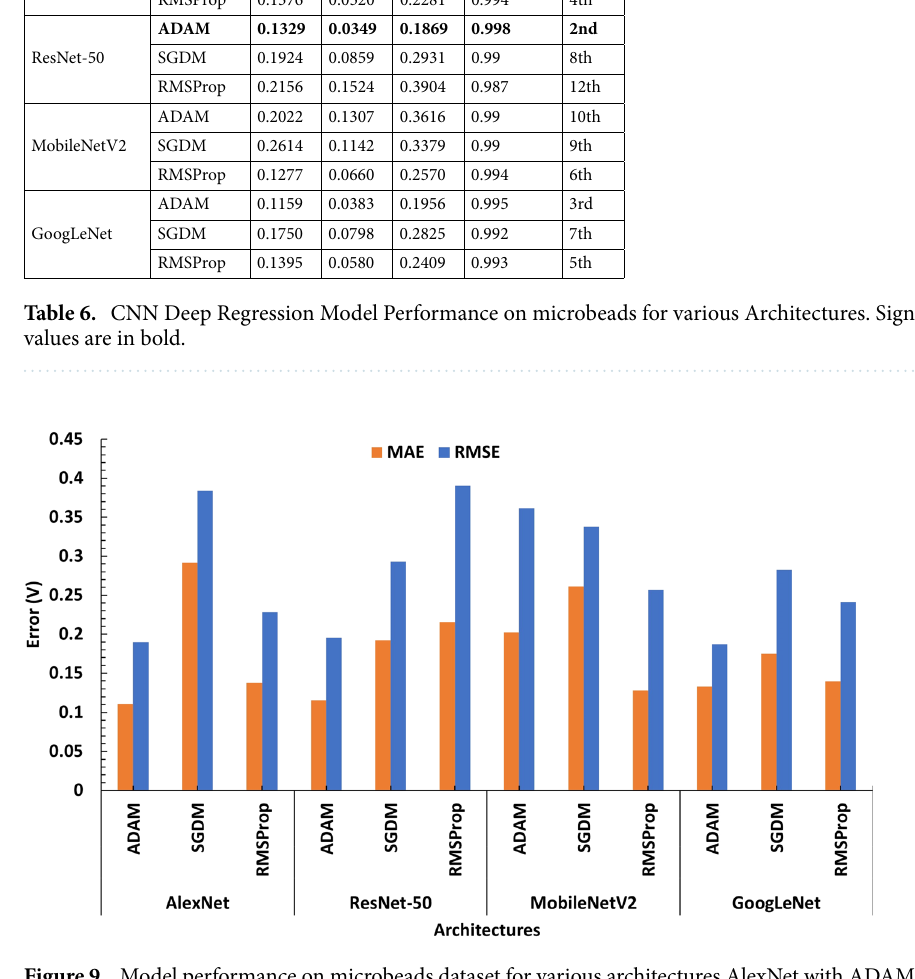
Figure 9. Model performance on microbeads dataset for various architectures AlexNet with ADAM optimizer has the best validation RMSE of 0.1745 on test dataset, followed by the same ResNet-50 but with ADAM optimizer having a validation RMSE of 0.1869.